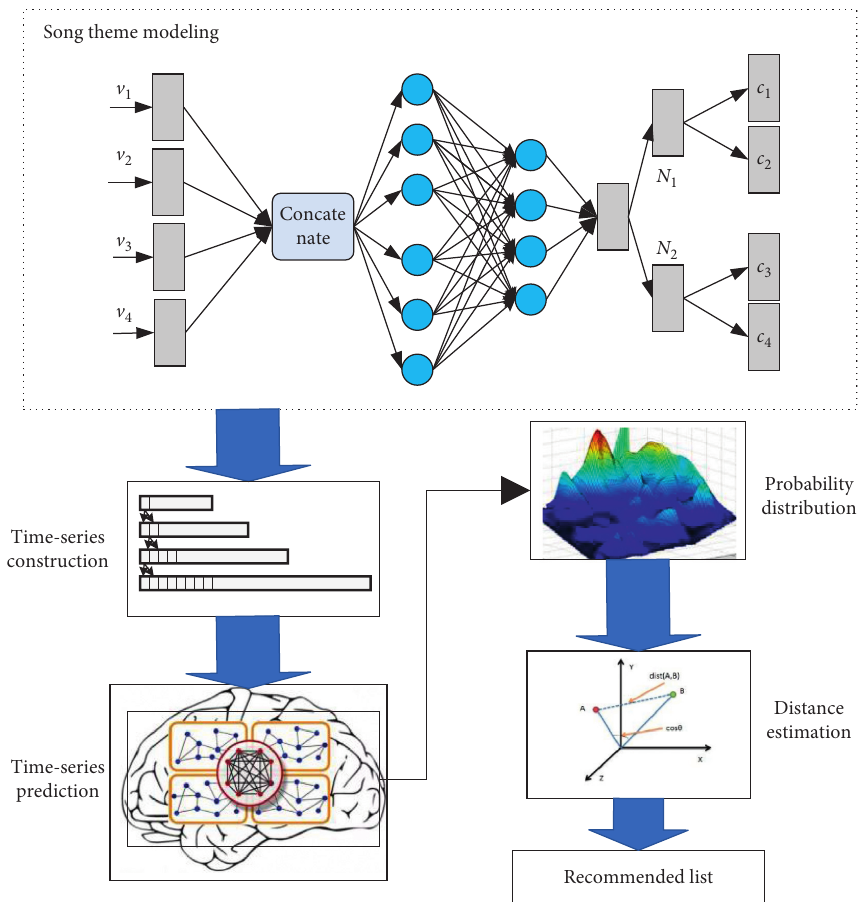
Figure 2: The implementation process of multidimension time-series